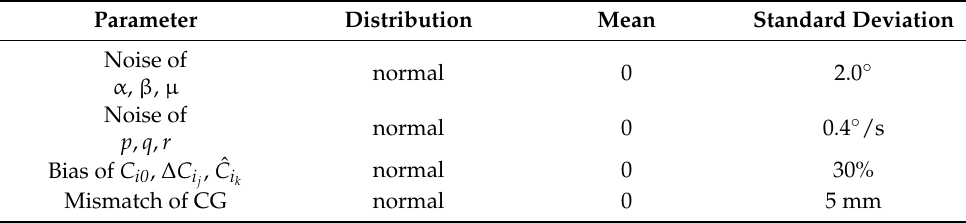
Table 4. Distributions for parameters affecting the